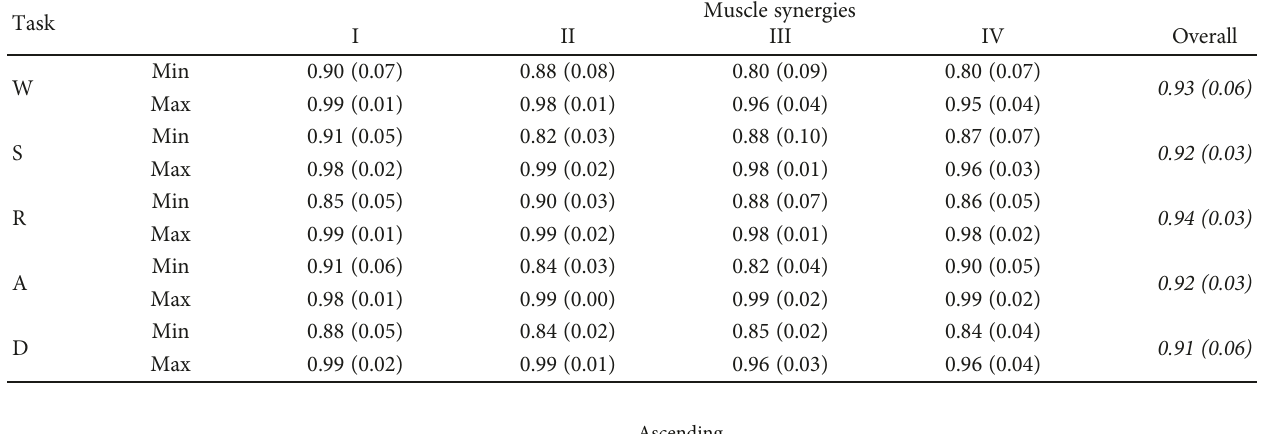
Table 5: Maximum and minimum and related standard deviation (SD) of WW R 2 related to each task. The overall means evaluated considering all the synergies together are reported in italic.